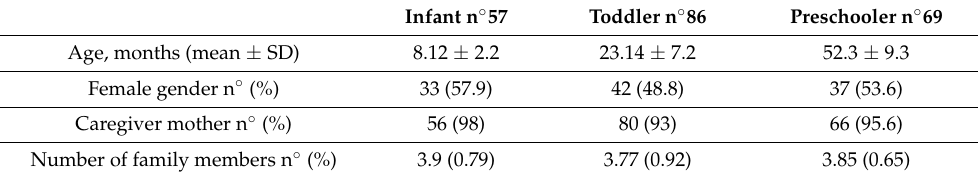
Table 1. Characteristics of the different age groups considered in the study.